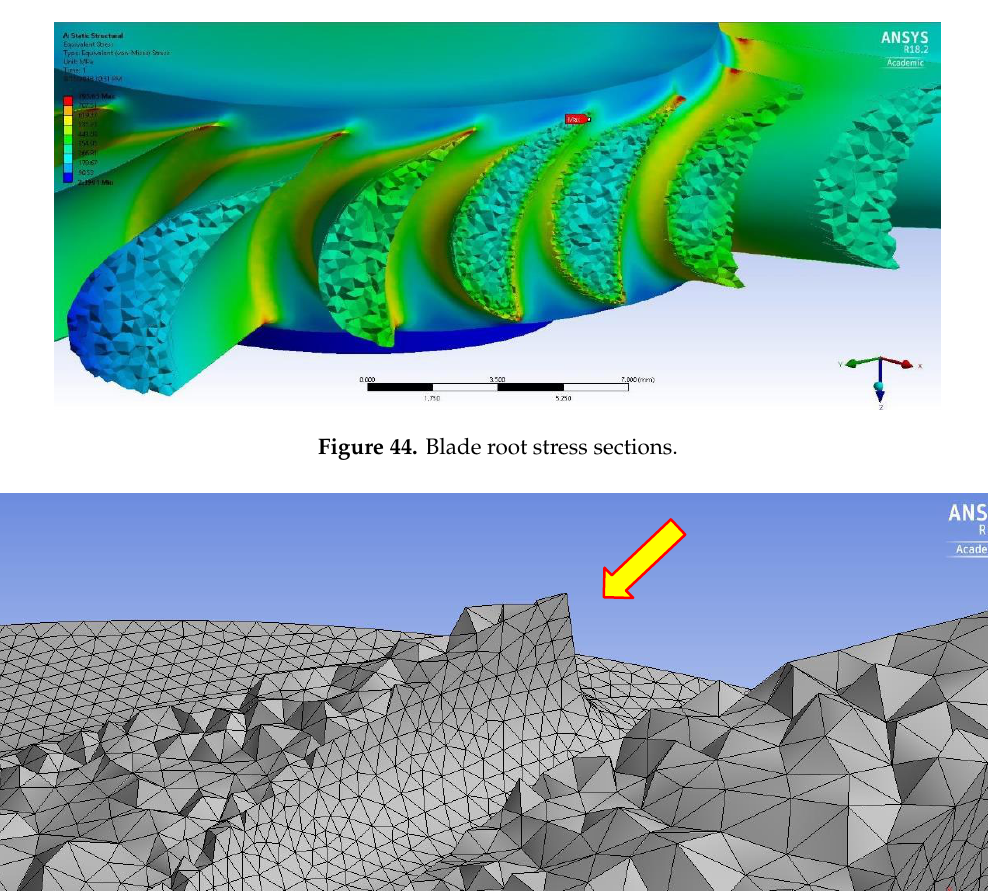
Figure 46. Safety factor (SF) distribution calculated at each mesh node (log 2 scale on the vertical axis). Regarding the rotor, no issues were highlighted as it is not rotating, and the nozzle blades are fixed at both hub and tip sections. The use of Inconel instead of steel was motivated to avoid creep and oxidation in long-term use. Note that the higher stress on the shroud elements in Figure 47 is due to two main factors: the no- displacement constraint (in reality, it would be able to dilatate because of the temperature at a rate similar to that of the casing), and the shroud being less thick than the chosen one illustrated in the next paragraph, due to the software settings. The stress is nevertheless less than the limit at maximum temperature. Further, this side of the shroud is not exposed to the flow, and thus being at an even cooler temperature, it would be significantly stronger than the blade.